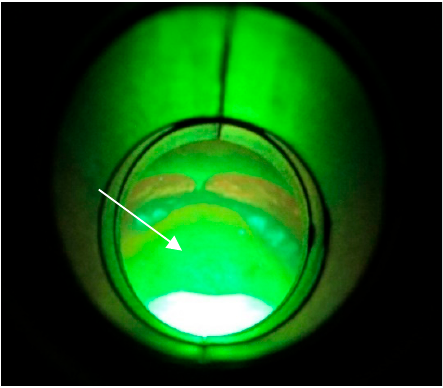
Figure 9. Colonized ThermoSens denture.